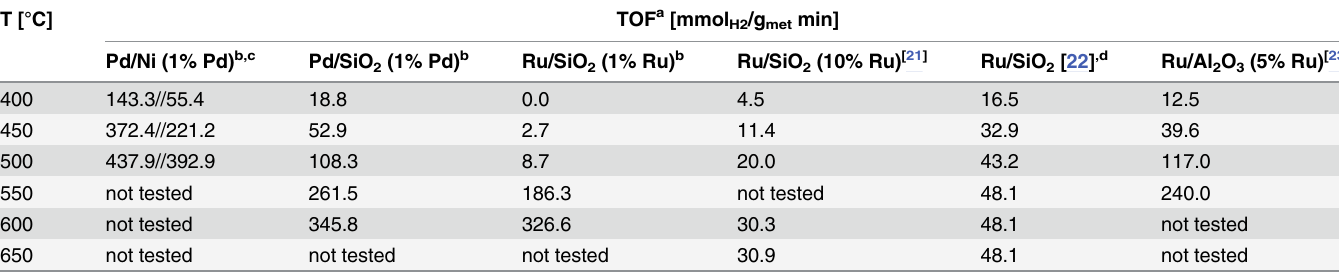
550 not tested not tested 650 not tested a/ TOF units as reported for the literature data for a fl ow of 3 dm 3 /h [21 – 23]; if calculated for NH 3 (data in text), TOF = V α / n, where V is the molar fl ow rate of NH 3 , α is the conversion degree and n is the moles of Me NPs (Me NP ). b/ investigated in this study c/ Pd/t-Ni // Pd/p-Ni at a fl ow rate of 2 dm 3 /h; TOF/T[°C] amounted to 120/400, 302/450, 1235/500 for a fl ow rate of 6 dm 3 /h or 79/400, 237/450, 1370/500, 2384/550, 2615/600 for a fl ow rate of 12 dm 3 /h, respectively. d/ The Si/Ru ratio was 0.2; BET surface area — 42 m 2